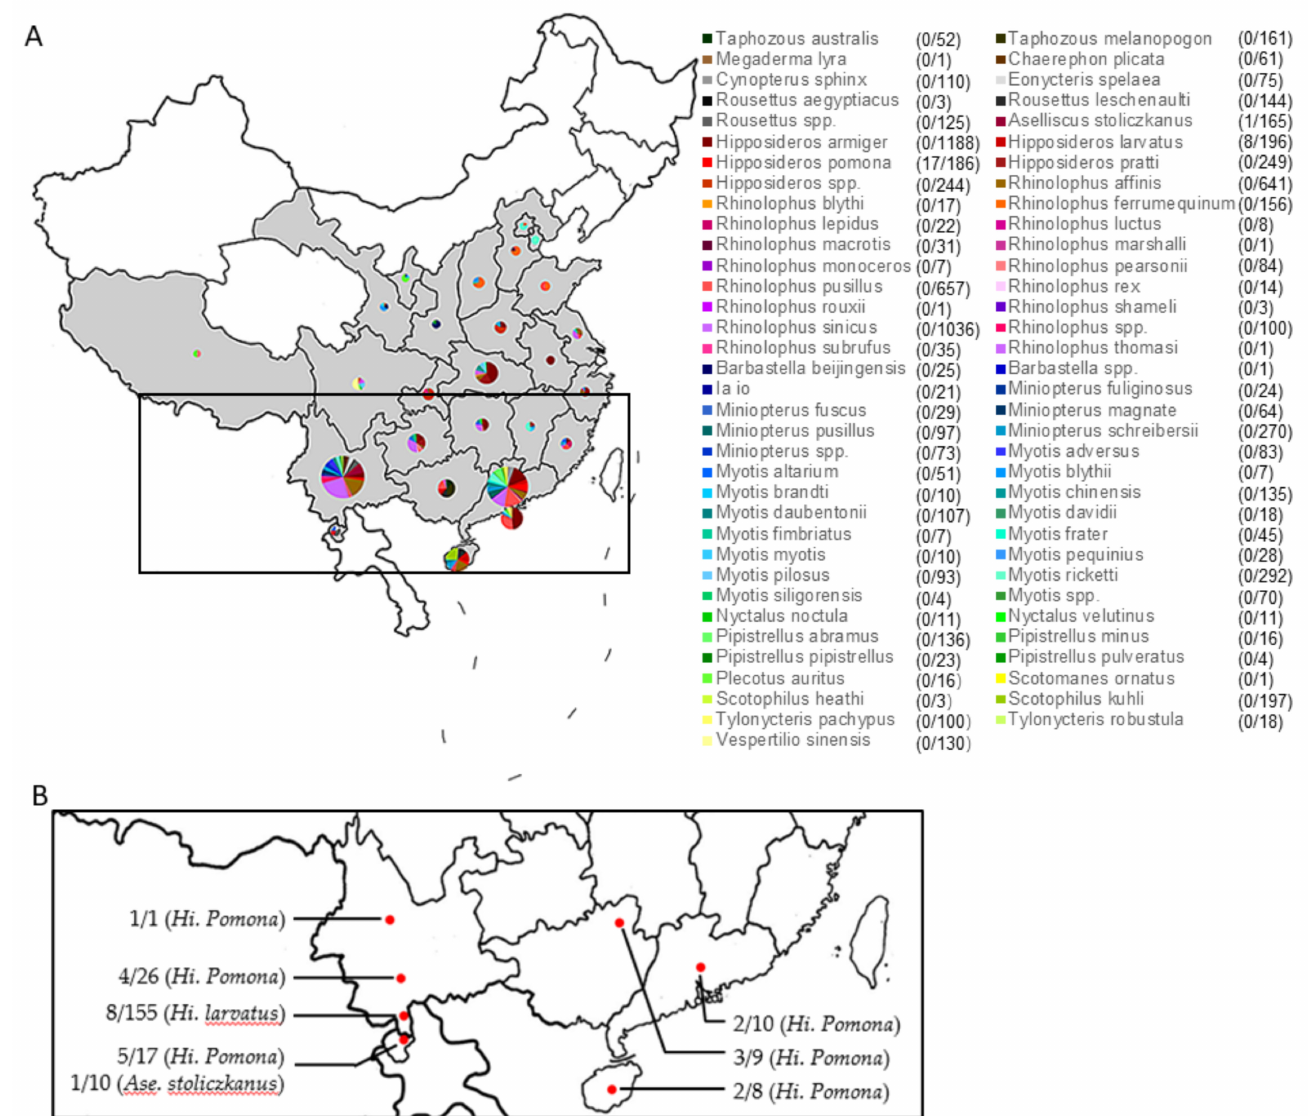
Figure 1. Locations of sampling ( A ) and BtCoV HKU10 positives ( B ). Sampling locations are in gray and bat species are listed in color. BtCoV HKU10 positives are marked in square ( A ) and in red dot ( B